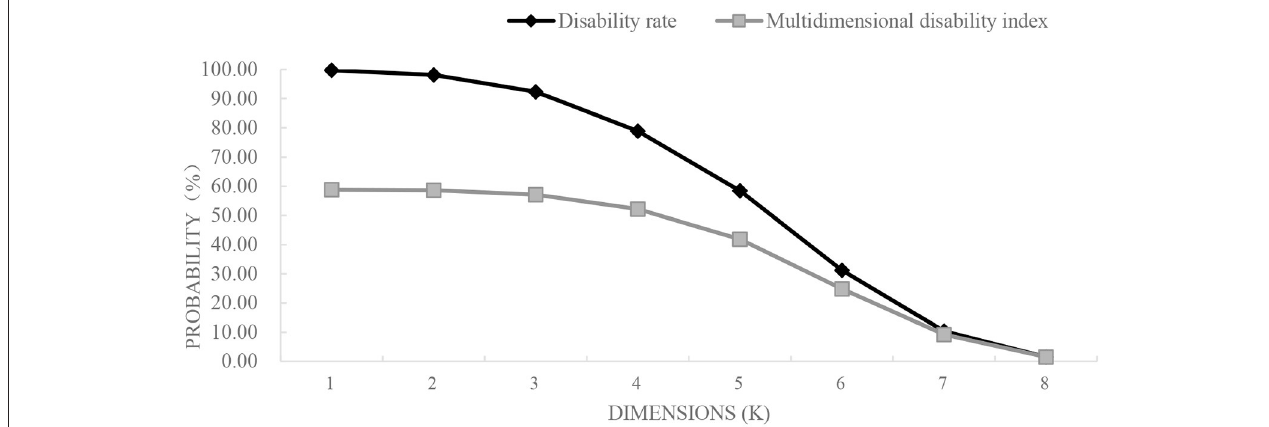
FIGURE 1 | H and M 0 occupancy relationship. H, disability rate; M0, multidimensional disability rate.